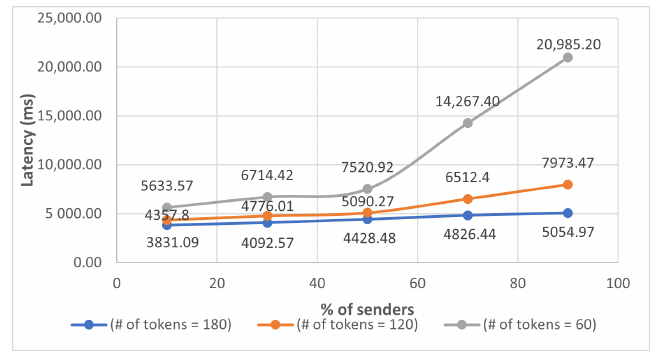
Figure 9. Latency vs. percentage of senders in Ring2Tor